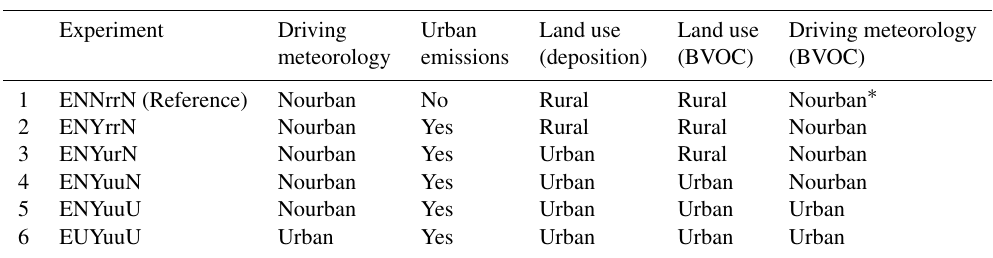
Table 2. The list of CTM simulations performed with information on the effects considered. The “driving meteorology” and “driving meteorology (BVOC)” columns correspond to the information from Table 1 above, i.e., which RCM simulation from the “Urban”–“Nourban” pair was